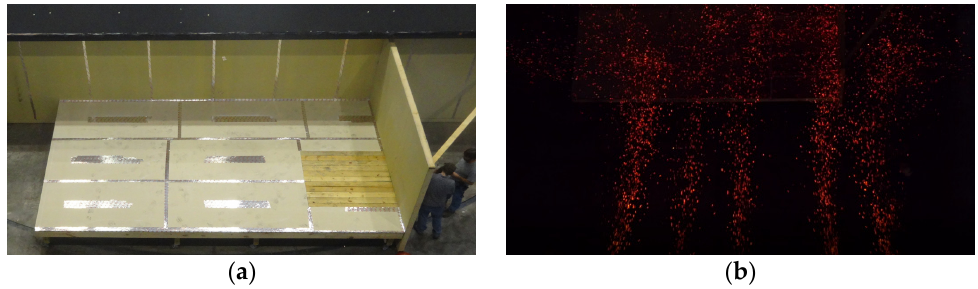
Figure 6. Test setup for ember exposure on decks. ( a ) test set up. ( b ) decks exposed to embers